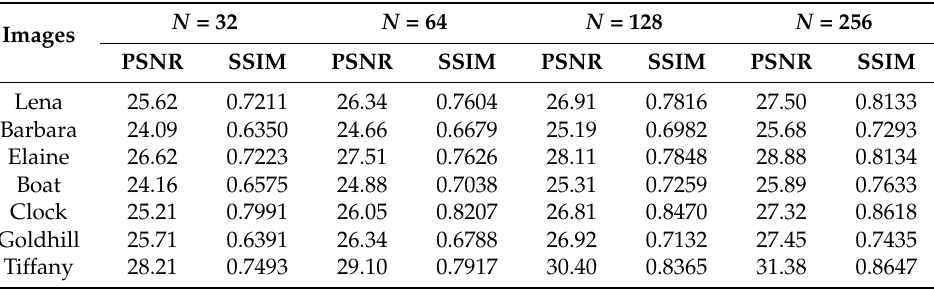
Table 14. PSNR (in dB) and SSIM of reconstructed images by using codebooks designed with the training set P-M-T, using